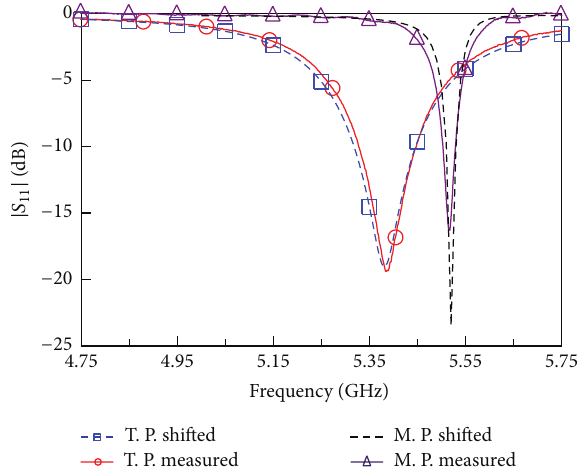
Figure 5: Measured and shifted simulated reflection coefficient comparison of the traditional antenna with quarter-wave trans- former and miniaturized antenna with longer feed line.